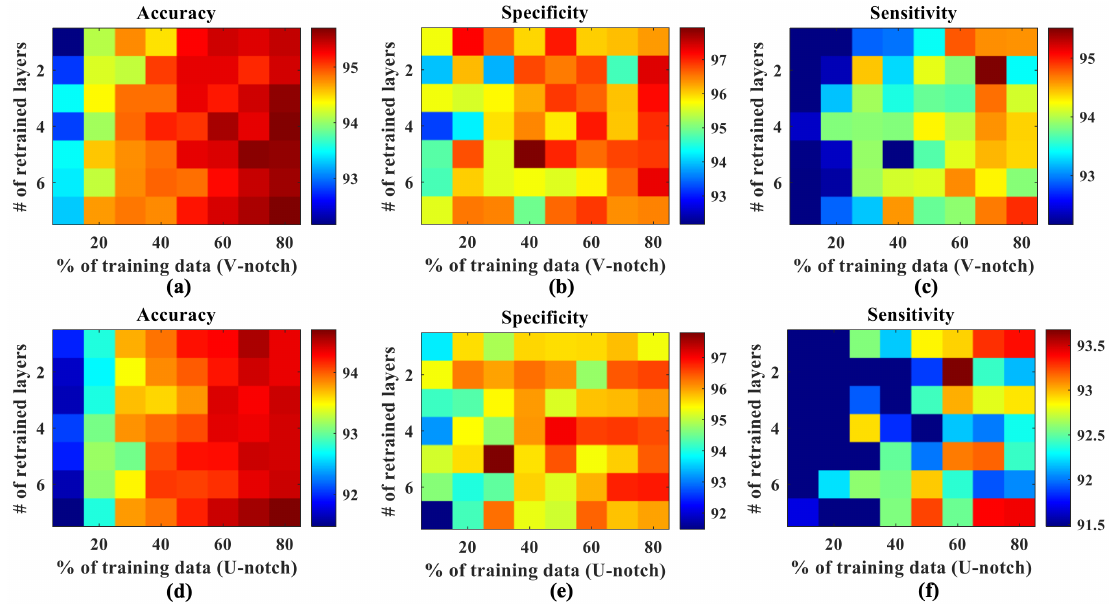
Figure 11. A composite effect of the number of retrained layers and percentage of training data when the baseline U-notch DNN is re-trained with V-notch data to enable a prediction for V-notch: ( a ) accuracy, ( b ) specificity, and ( c ) sensitivity. A composite effect of the number of retrained layers and percentage of training data when the baseline V-notch DNN is retrained with U-notch data to enable a prediction for U-notch: ( d ) accuracy, ( e ) specificity, and ( f )